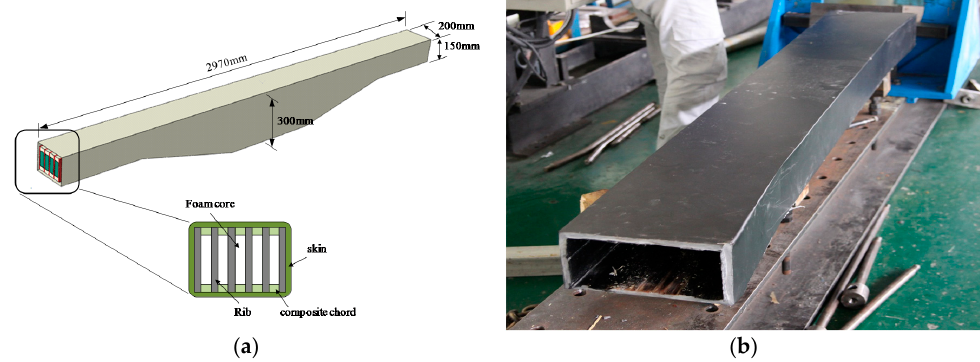
Figure 3. Internal structure of the composite bogie frame: ( a ) composition of composite side beam with rib, foam core, composite chords, and skin; ( b ) composite crossbeam formed in an autoclave. The ribs were built beforehand using a resin infusion method with a mixture of quadriaxial glass fiber fabric and epoxy resin. The ribs were attached to foam cores using FM73 adhesive film. The composite chords located above and below the foam core were created from 72 layers of 4 ‐ harness satin fabric glass/epoxy pre ‐ pregs, which were stacked on top of each other. This internal structure was subjected to a 6 h ‐ long forming process in an autoclave [13]. After the process was completed, 56 layers of GEP224 pre ‐ pregs were stacked on top of the structure to form the skin. After this, another 6 h ‐ long forming process in the autoclave was performed to finally complete the formation of the composite side beams. The finally formed composite side beam was 2970 mm long and 200 mm wide.